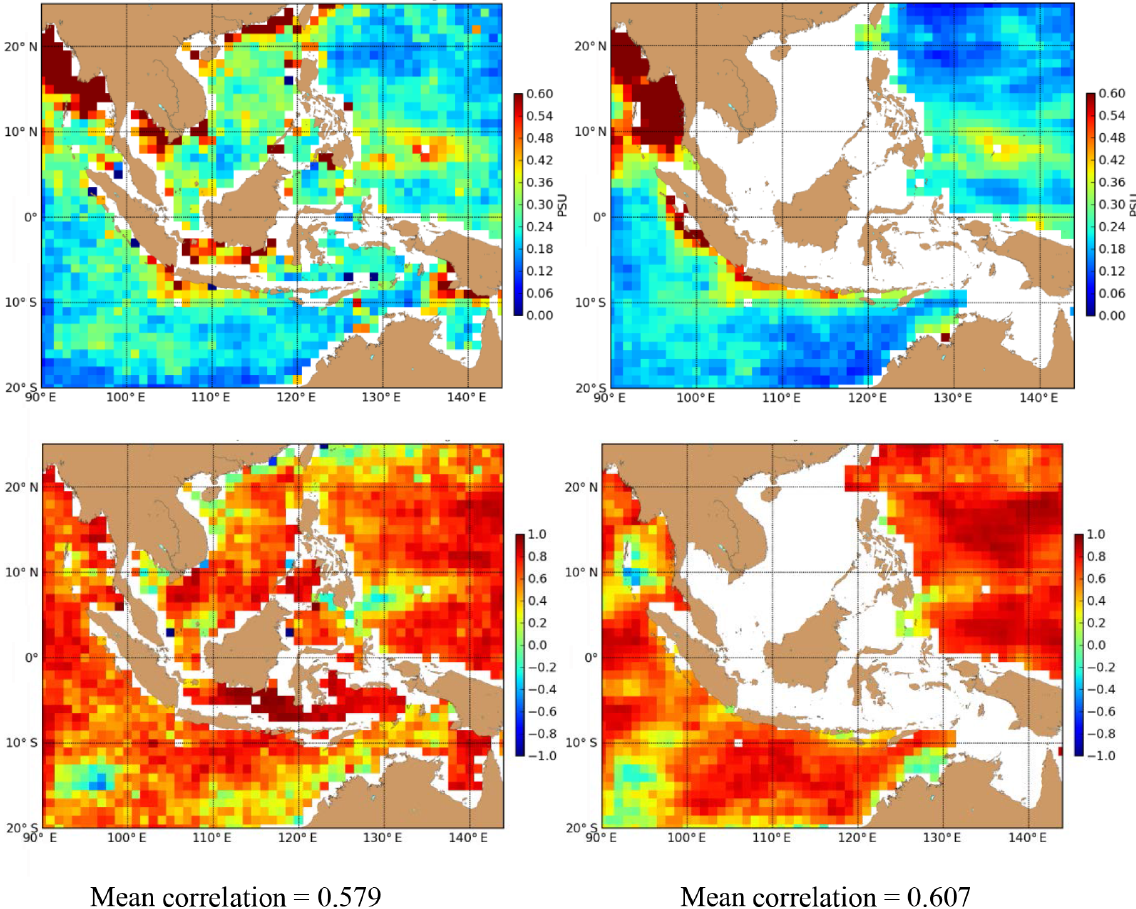
Figure 8. RMSD (top) and correlation (bottom) of INDO12 with respect to Aquarius (left) and JAMSTEC (ARGO + TRITON + CTD) (right) monthly map from August 2011 to December